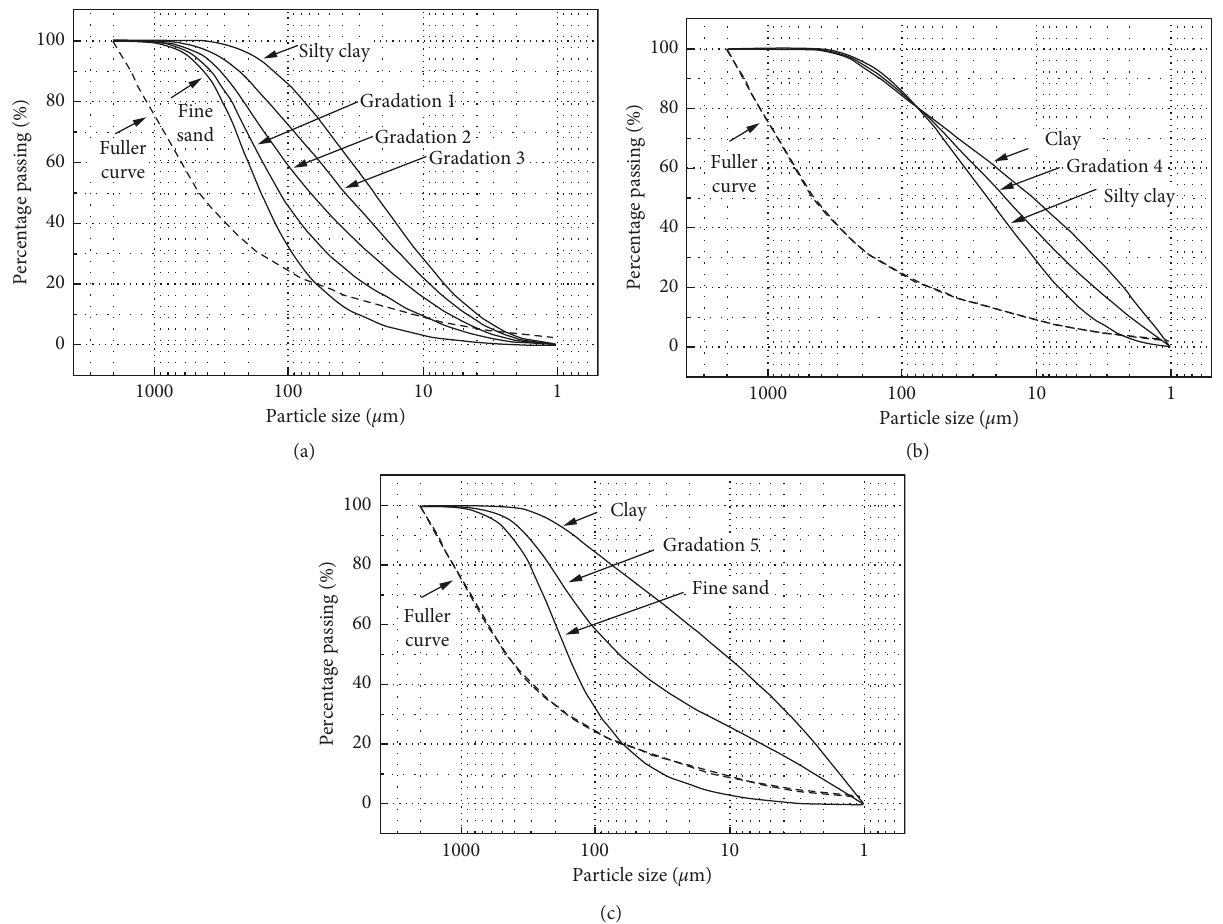
Figure 8: Particle size distribution curves of mixed soil: (a) fine sand and silty clay; (b) clay and silty clay; (c) clay and fine sand.